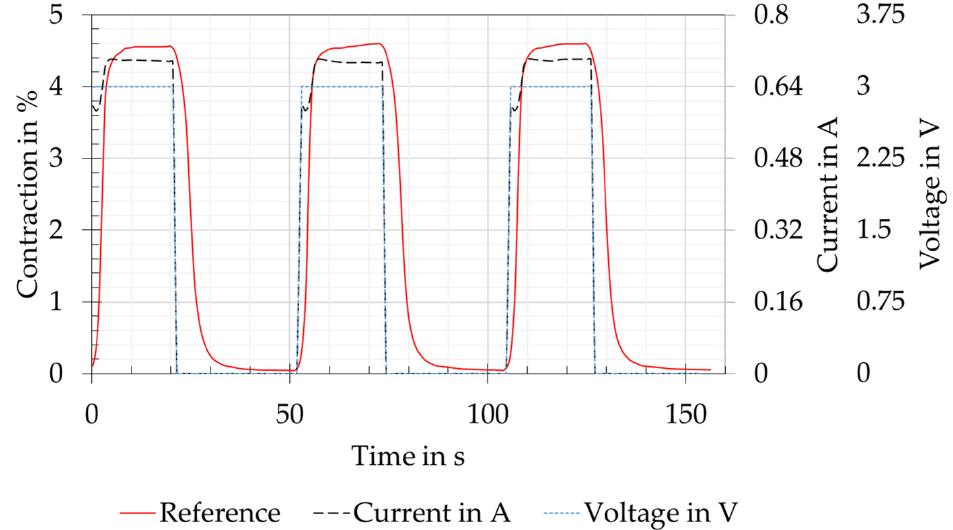
Figure 8. Relationship between the electric current, the voltage, and the contraction of the SMA wire actuator on the basis of a reference measurement with a clamped straight wire. A constant voltage of 3 V was applied for each contraction cycle of the SMA